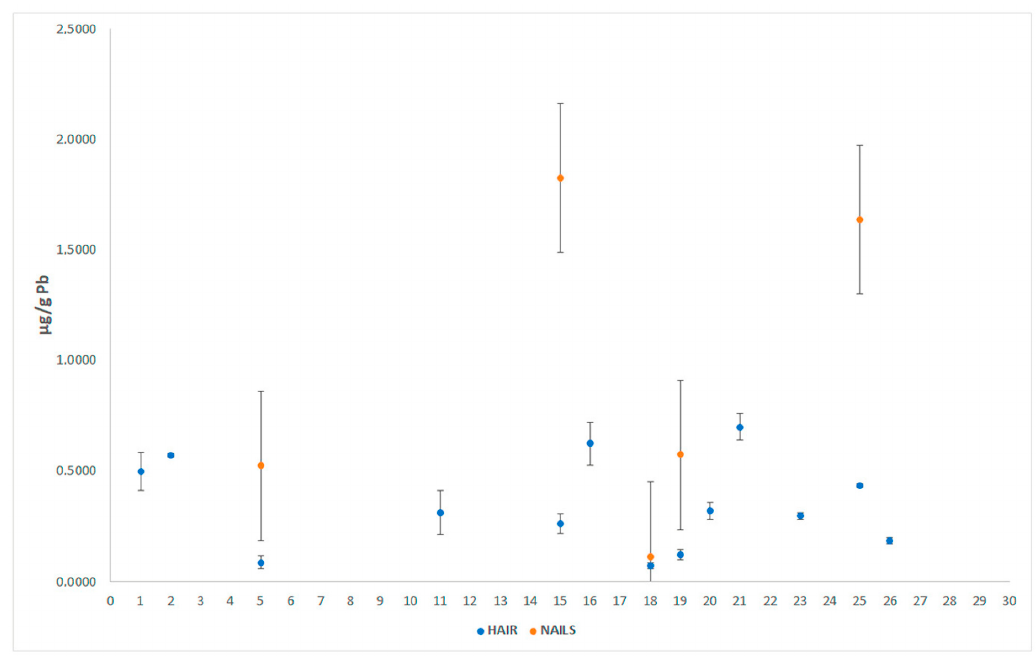
Figure 6. Lead (Pb) concentrations in human hair and nail samples.